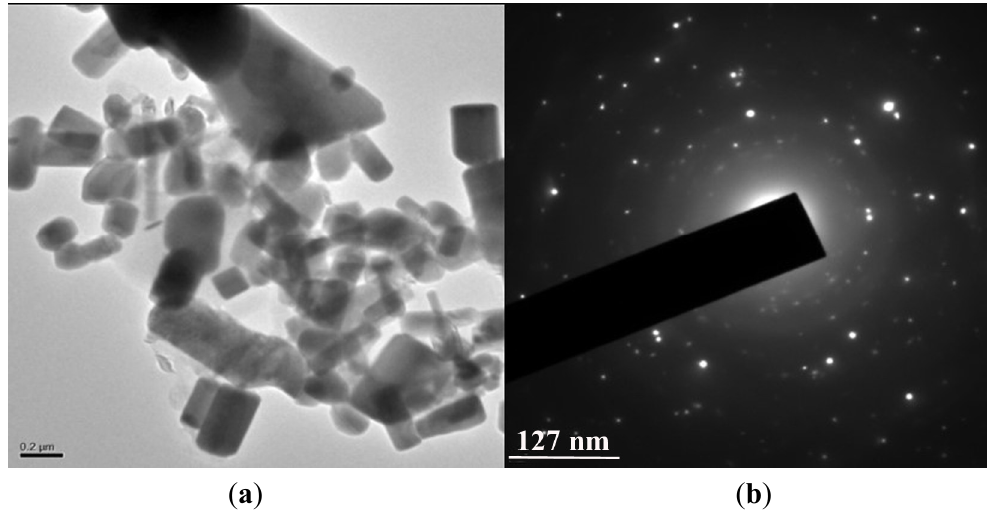
Figure 4. ( a ) High-resolution transmission electron microscopy (HRTEM) image showing synthesized ZnO NPs from E . prostrata leaf extract; ( b ) Selected area of electron diffraction pattern (SAED) of the synthesized ZnO NPs showing the